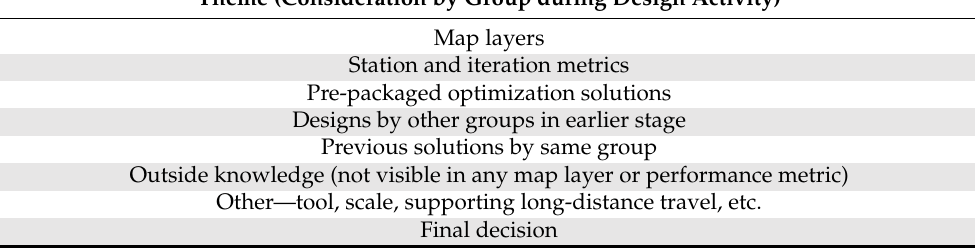
Table 2. Themes considered by groups and captured by notetakers during the Hartford geodesign workshop.